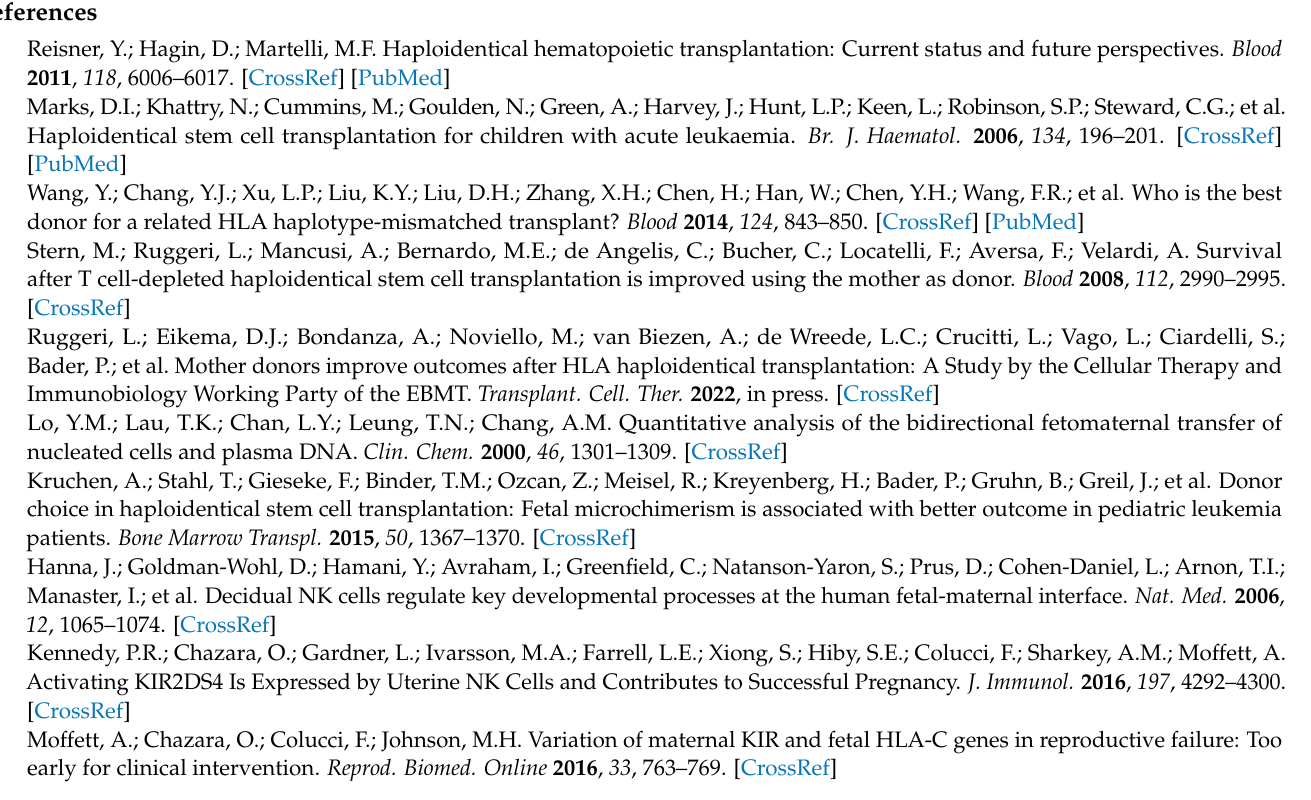
Table S3: n-values to supplementary Figures 1–3. Figure S1: Child, mother and father were HLA-C genotyped and grouped according to their HLA-C into HLA-C1/C1 (C1), HLA-C1/C2 (C1/2) or HLA-C2/C2 (C2). Figure S2: B content score frequencies in the analyzed cohort. Figure S3: Parental cytotoxicity against filial leukemic